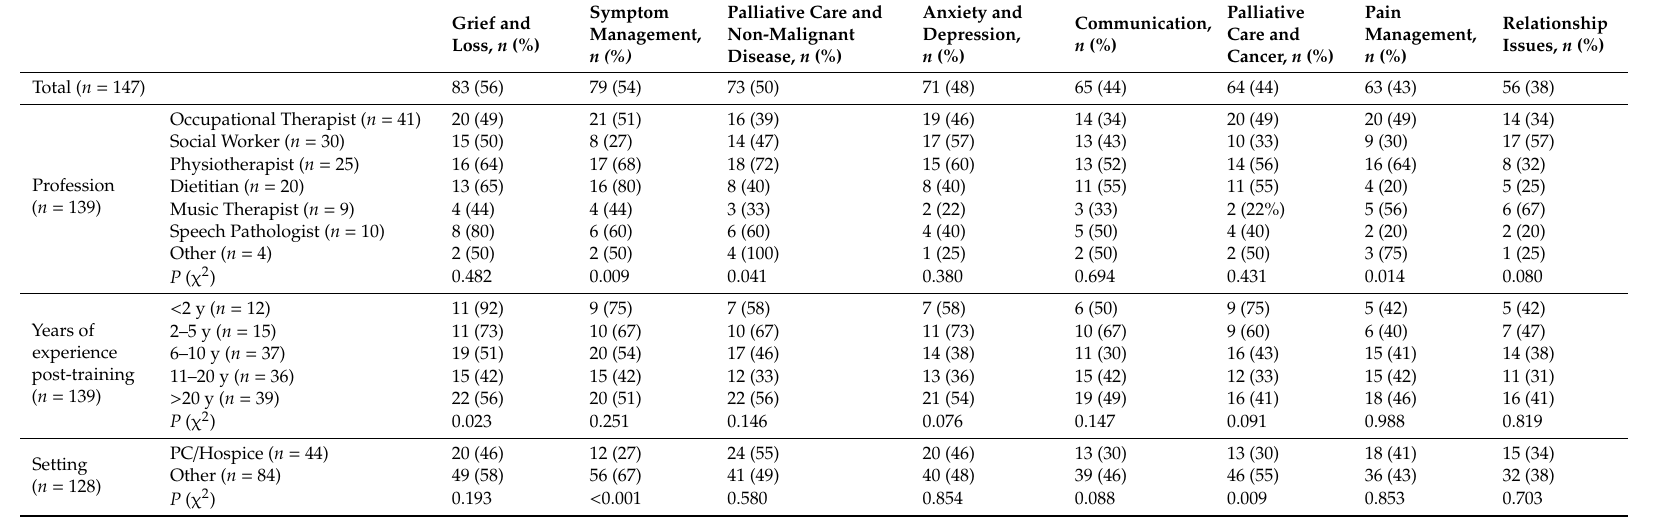
Table 2. Palliative care educational needs by discipline, years of experience and practice